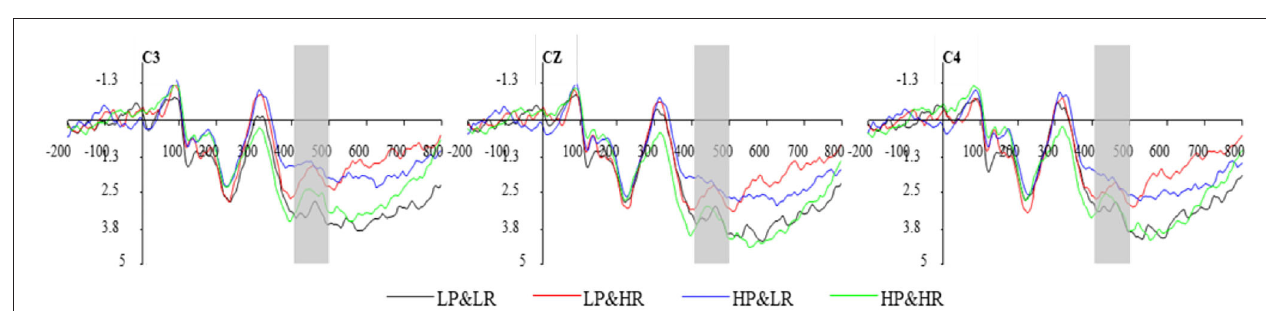
FIGURE 7 | The average waveform of N400 component at C3, Cz, and C4.